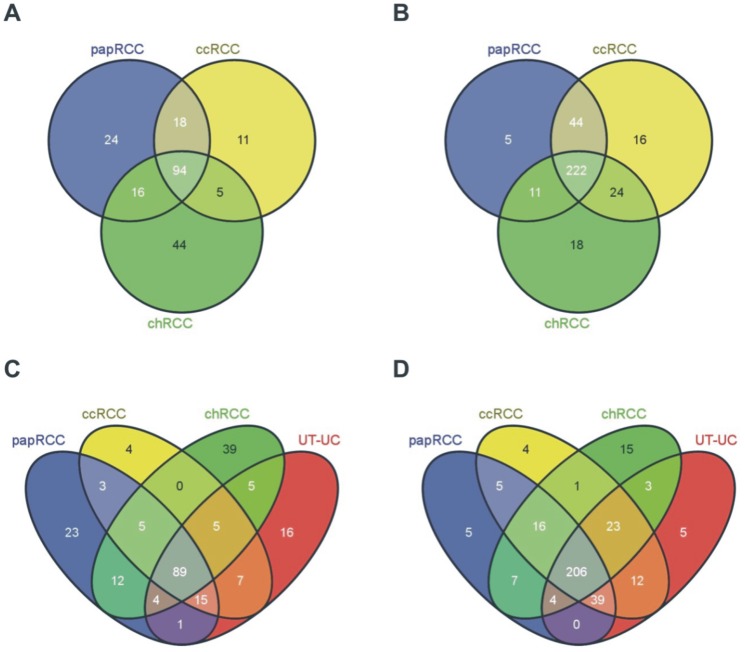
Overlapping relationship of the deregulated miRNAs.Venn diagrams illustrate the overlapping relationship of the number of up-regulated miRNAs among RCC subtypes (A), down-regulated miRNAs among RCC subtypes (B), up-regulated miRNAs among RCC subtypes and UT-UCs (C), down-regulated miRNAs between RCC subtypes and UT-UCs (D). Ninety-four miRNAs were co-upregulated among ccRCC, papRCC and chRCC; and 11, 44 and 24 miRNAs were specifically up-regulated in each one of the three RCC subtypes (ccRCC, chRCC and papRCC), respectively. On the other hand, 222 miRNAs were co-down-regulated in the three RCC subtypes, whereas 16, 18 and 5 miRNAs were specifically down-regulated in ccRCC, chRCC and papRCC, respectively. When the DE miRNAs in each RCC subtype were combined with those in UT-UC, we identified 89 and 206 miRNAs that were up- and down-regulated, respectively in all tumor types.